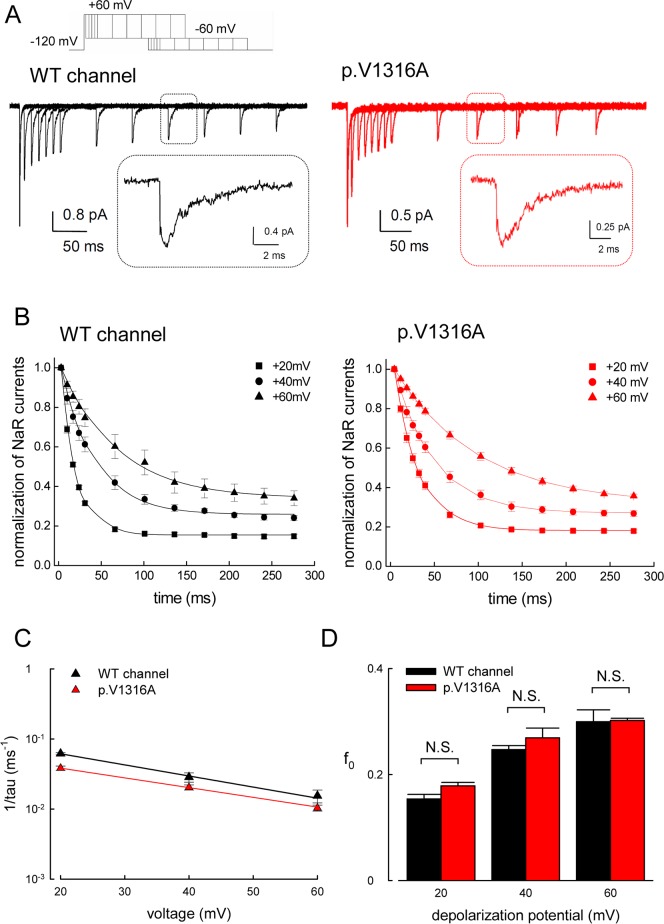
Smaller resurgent Na+ currents with lengthening of the depolarization prepulse.(A) The cell was first held at –120 mV, and then stepped to a gradually lengthened depolarization prepulse at +60 mV before stepped to –60 mV for 280 ms to document the resurgent currents. Note that the resurgent Na+ currents get smaller with lengthening of the prepulse in the WT and p.V1316A mutant channels. Sample resurgent Na+ currents magnified in time scale are shown in inset figures. (B) The normalized amplitude of resurgent Na+ currents (normalized to the first current in each series) is plotted against the length of the prepulse (to +20, +40, and +60 mV, the protocols were the same as that in part A). The lines are fits to the data points of the form: normalized resurgent currents = (1–fo)× exp(–(x–3)/τ)+ fo, where x is the prepulse length in ms. τ and fo are 16.34 ms and 0.15 for +20 mV, 37.6 ms and 0.26 for +40 mV, and 64.88 ms and 0.34 for +60 mV prepulse, respectively, in the WT channel (each n = 7). On the other hand, τ and fo are 28.73 ms and 0.18 for +20 mV, 44.41 ms and 0.27 for +40 mV, and 98.84 ms and 0.31 for +60 mV prepulse, respectively, in the p.V1316A mutant channel (each n = 7). (C) The inverses of time constants in part B are plotted against the prepulse voltage in semi-logarithmic scale. The data are fitted with the following equation 1/tau(V) = 0.13×exp(–0.9V/25) ms–1 for the WT channel, and 1/tau(V) = 0.07×exp(–0.8V/25) ms–1 for the p.V1316A mutant channel, respectively, where V is the prepulse potential in mV. (D) The fo (the residual resurgent Na+ currents) in part B are plotted against different depolarization potentials (e.g., +20, +40, and +60 mV) in the WT and p.V1316A mutant channels. Note that there is no significant difference between the WT and p.V1316A mutant channels at each voltage (n = 7; N.S., no statistically significant difference). Individual data is shown in the file of S1 Data.